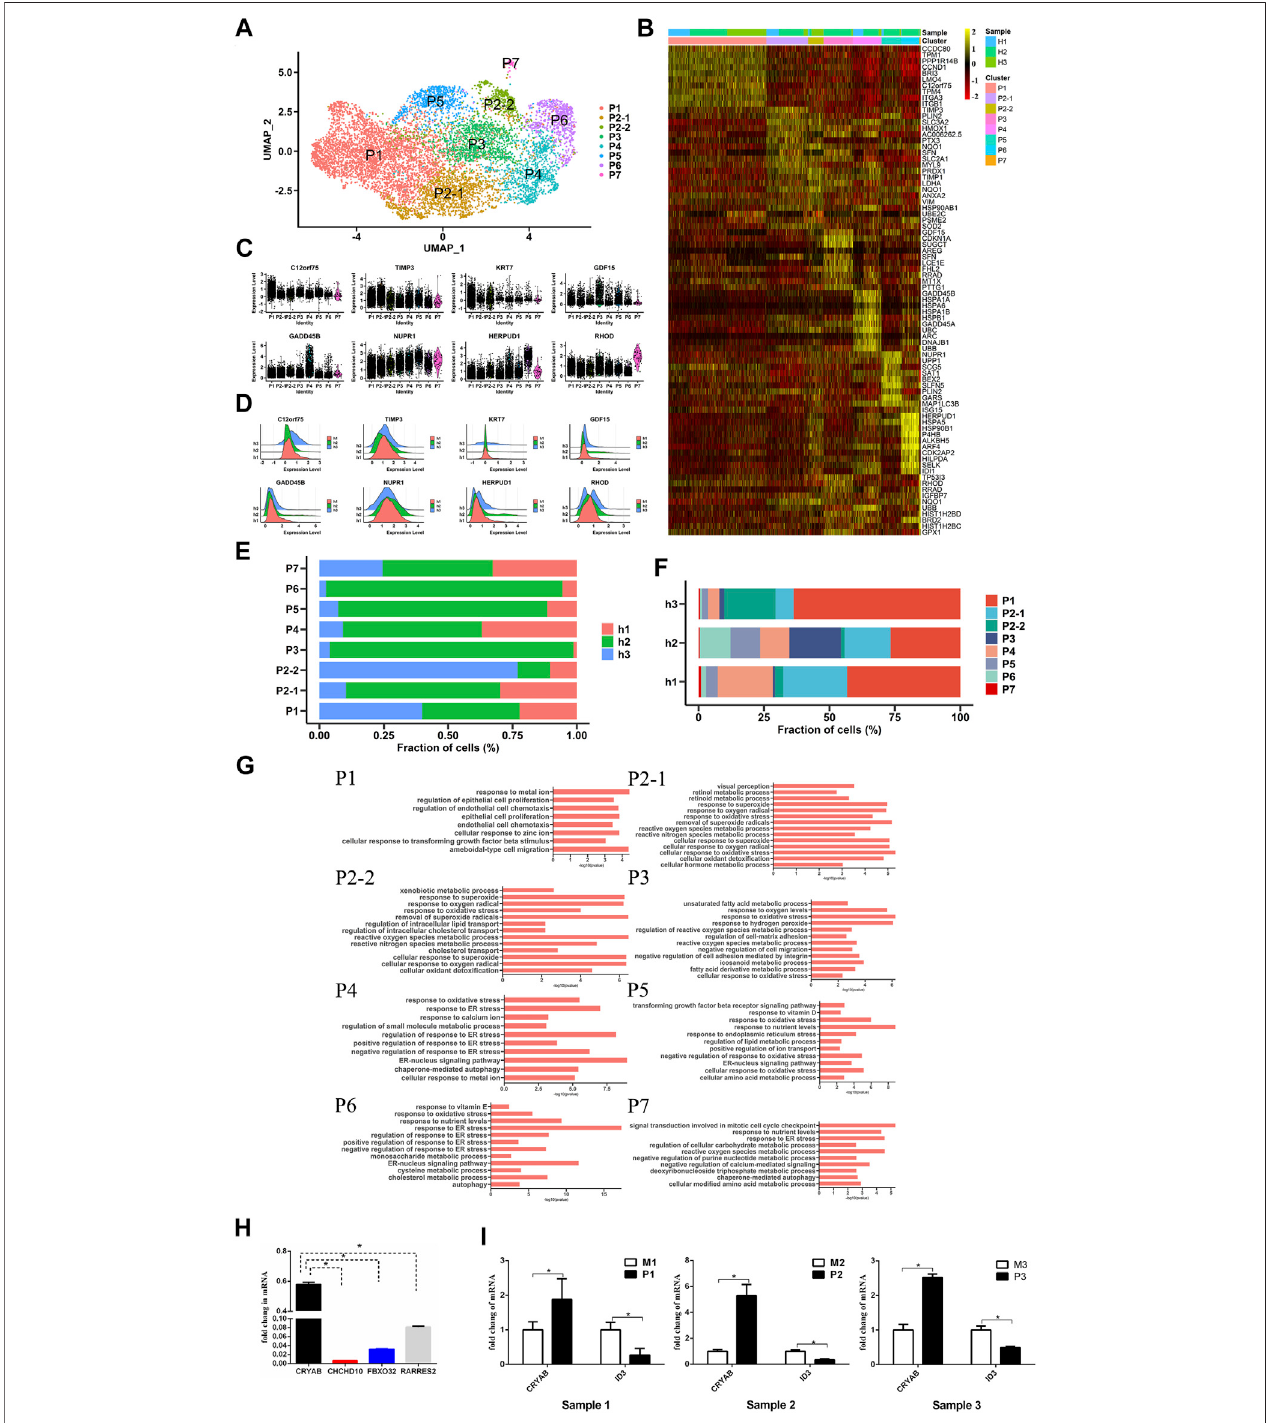
FIGURE 3| Single-cellRNA-seq transcriptome pro fi ling of peripheral RPE (A). UMAP plot shows the cell classi fi cation ofperipheral RPE cells in three samples (B). Heatmap of eight peripheral RPE subpopulations. Columns are divided into eight types of cells, and rows represent gene names and can be used to identify eight subpopulations.Theheatmapscalerepresentsthenormalizedexpressionvalue (C). Violinplotsshowing8clustersofperipheralRPE-speci fi cgenes (D). Theexpression patternsofthedifferentiallyexpressedgenesinthethreesamples.The X -axisshowsthelevelofgeneexpression (E). Theproportionofeachsampleineachcluster (P1, P2-1, P2-2, P3, P4, P5, P6, P7) (F). The proportion of each cluster (P1, P2-1, P2-2, P3, P4, P5, P6, P7) in each sample (G). Gene Ontology (GO) terms associated with genes with upregulated expression in each peripheral RPE population (H). RT-PCR analysis of differentially expressed genes with high speci fi c expression in peripheral RPE. *: p < 0.05 (I). Veri fi cation of peripheral RPE markers and macular RPE markers by RT-PCR.